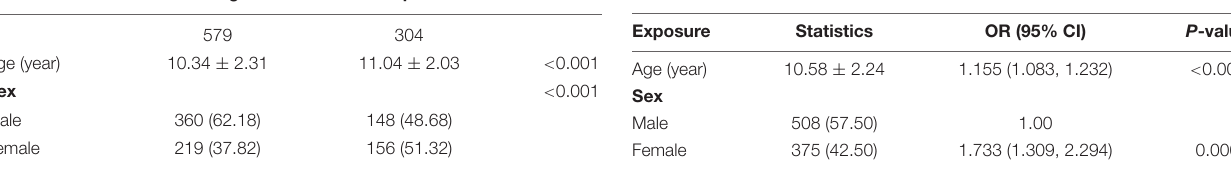
TABLE 3 | Univariate analysis of age and sex on HUTT-positive results [ n = 883, mean ± SD, n